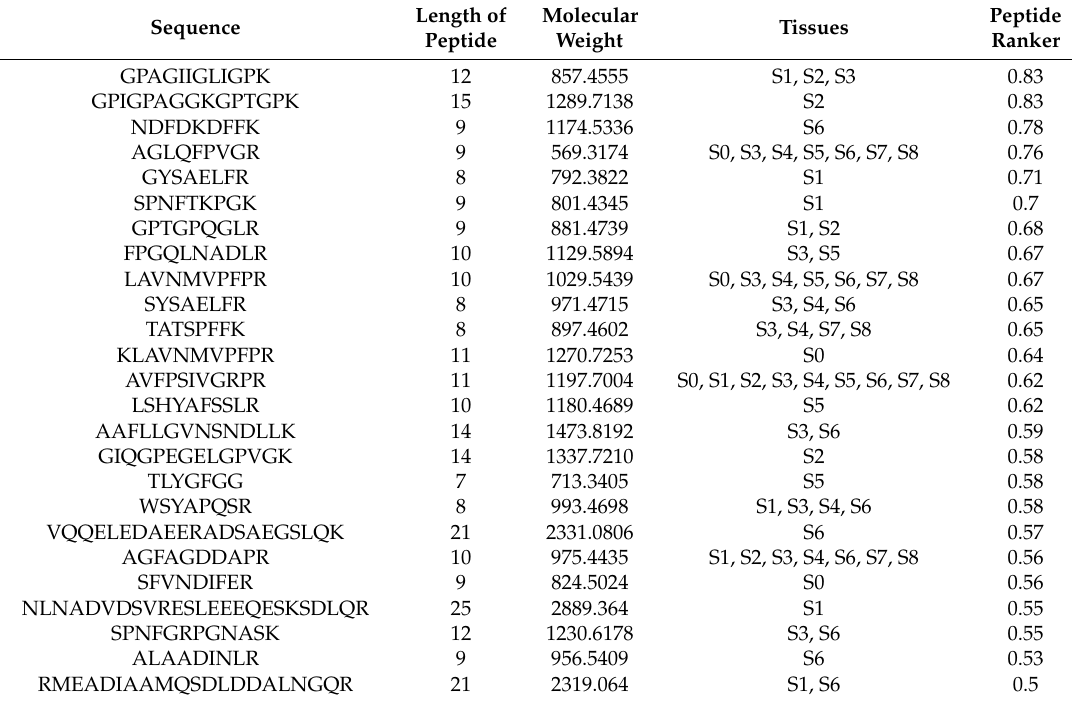
Table 1. Peptides released from Mytilus edulis proteins hydrolyzed by trypsin. Length Sequence